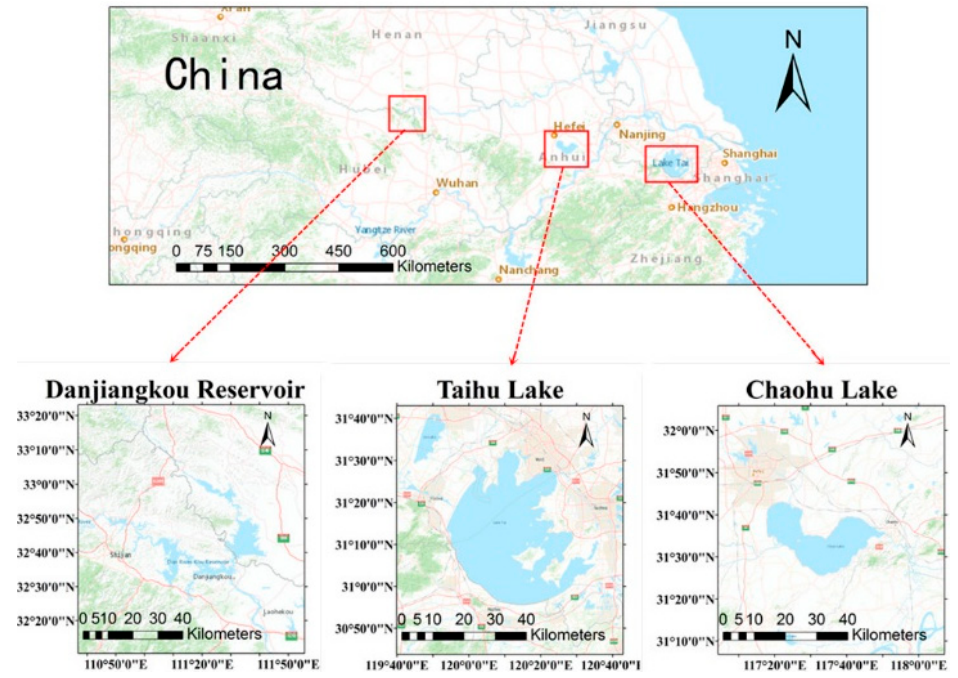
Figure 1. Study areas, including Danjiangkou Reservoir, Taihu Lake, and Chaohu Lake.